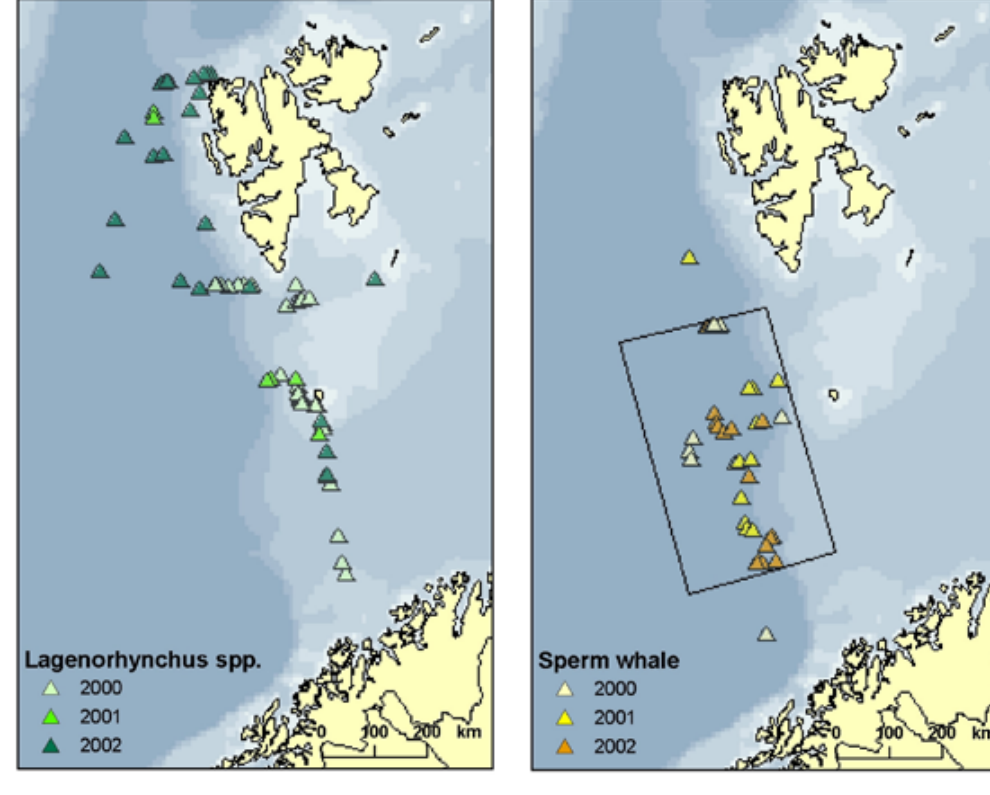
Fig. 10. Distribution of Lagenorhynchus dolphins in 2000, 2001 and 2002.